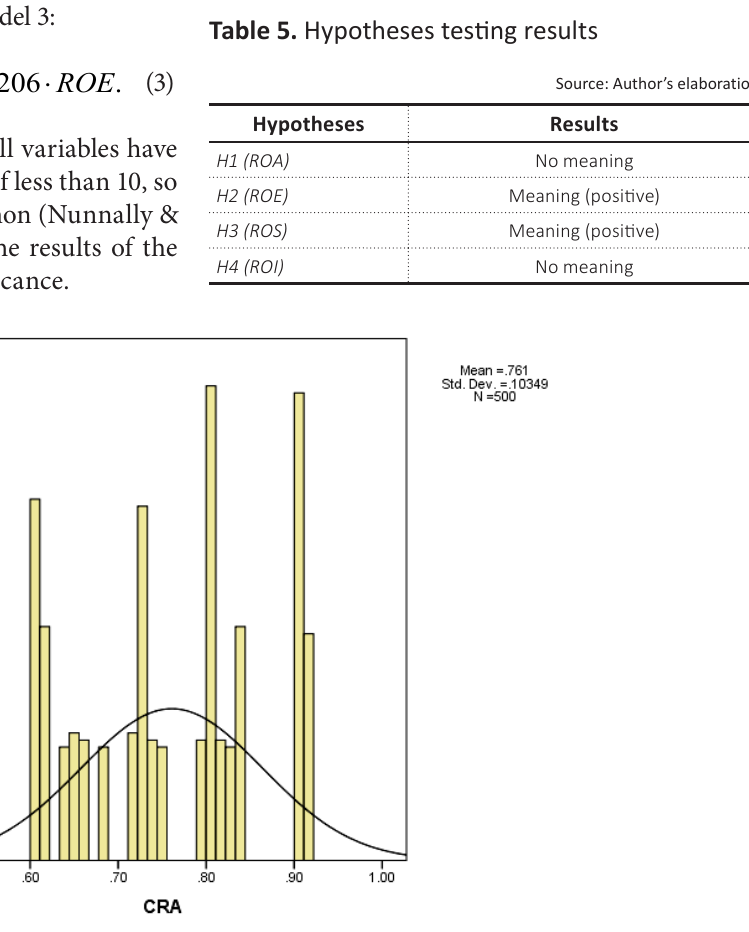
Table 5. Hypotheses testing results